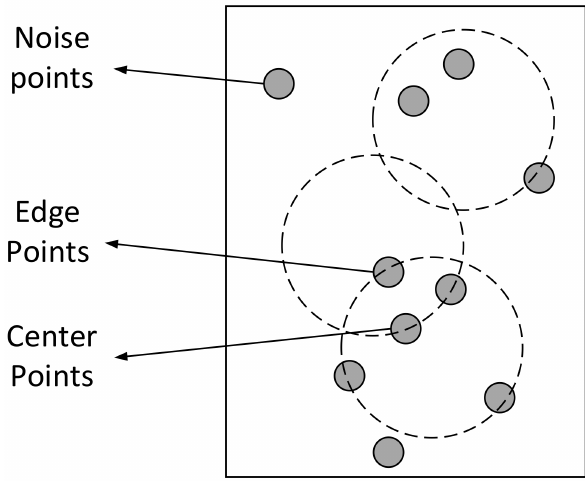
Figure 2. Instantiated description of the node